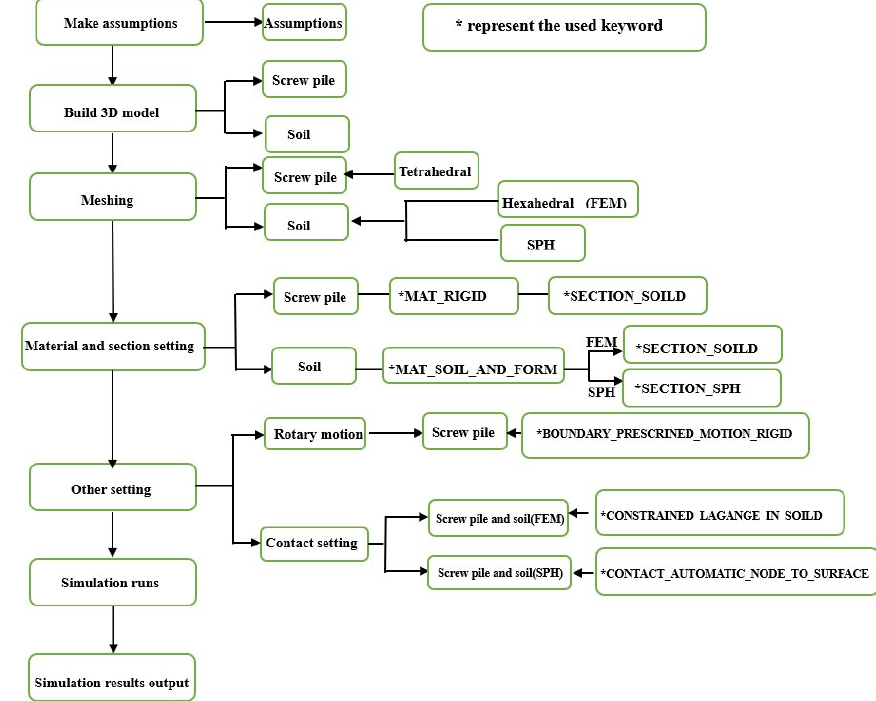
Figure 5. Flow chart of simulation.